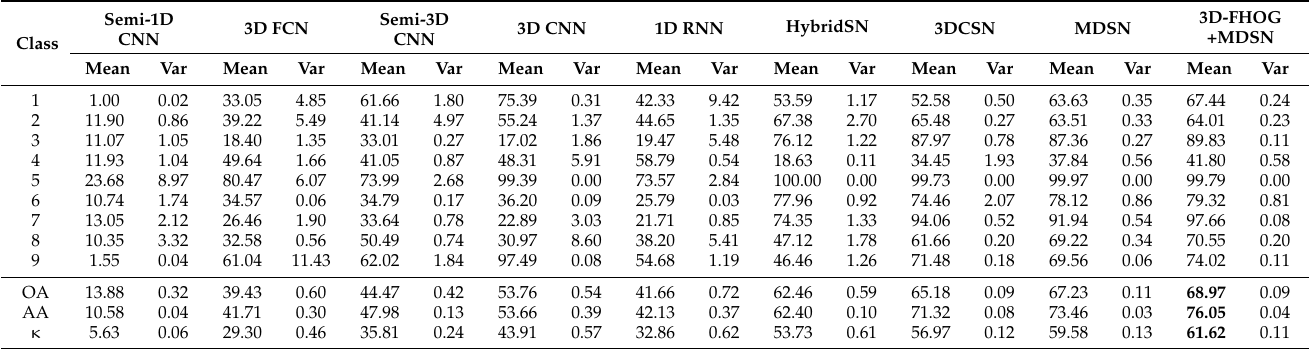
Table 9. Classification results (%) for eight different CNN-based methods and 3D-FHOG + MDSN on the test set of PU data set, with three labeled samples per class as training set.